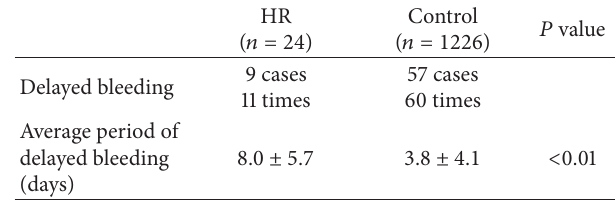
Table 5: Delayed bleeding after ESD with or without